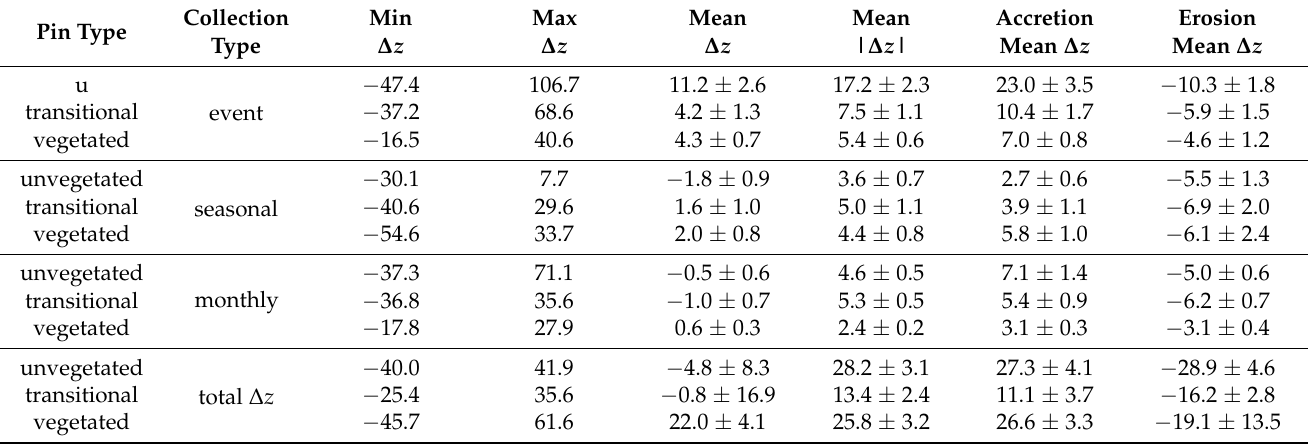
overestimated ∆ z flight one to two and one to three. In flights two to three, the UAS